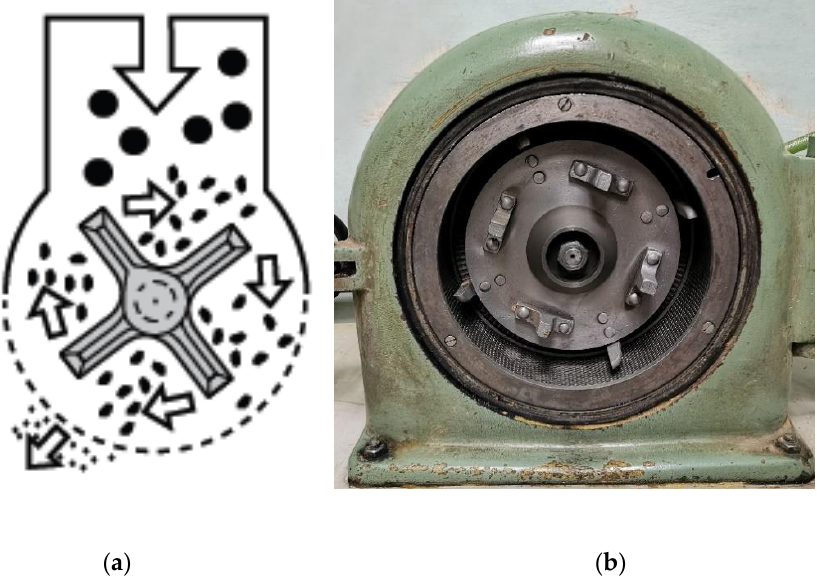
Figure 11. A hammer mill: ( a ) schematic of the mill; ( b ) an example of the real-world hammer mill.